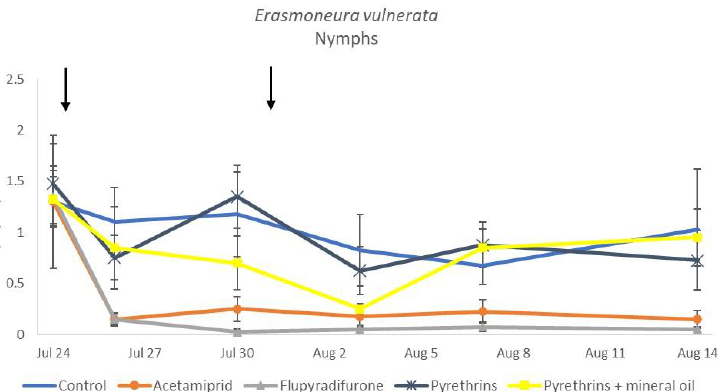
Figure 12. Dynamics of Erasmoneura vulnerata nymphs (mean ± std. err.) in the 2019 trial. Insecticides were applied one (first arrow) or two times (second arrow, see Materials and Methods section).